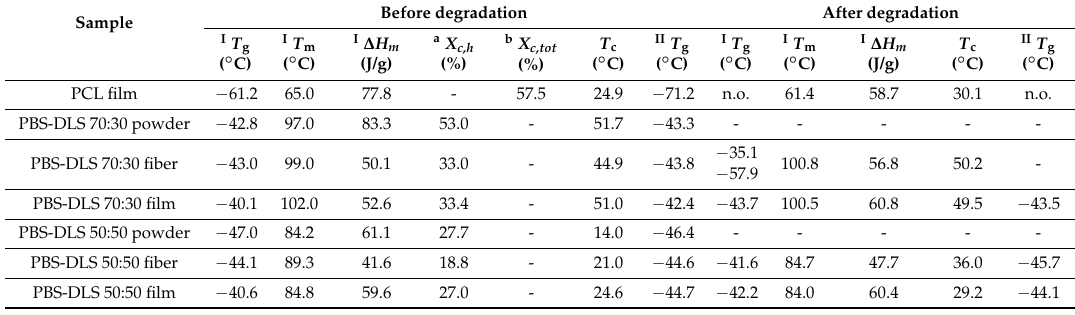
Table 3. Thermal behavior of PBS-DLS 70:30 and 50:50 copolymers before and after degradation.